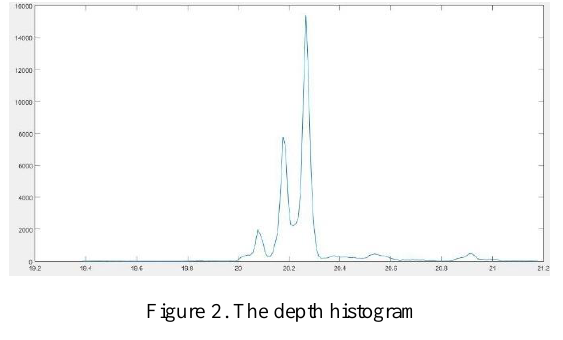
Figure 2. The depth histogram